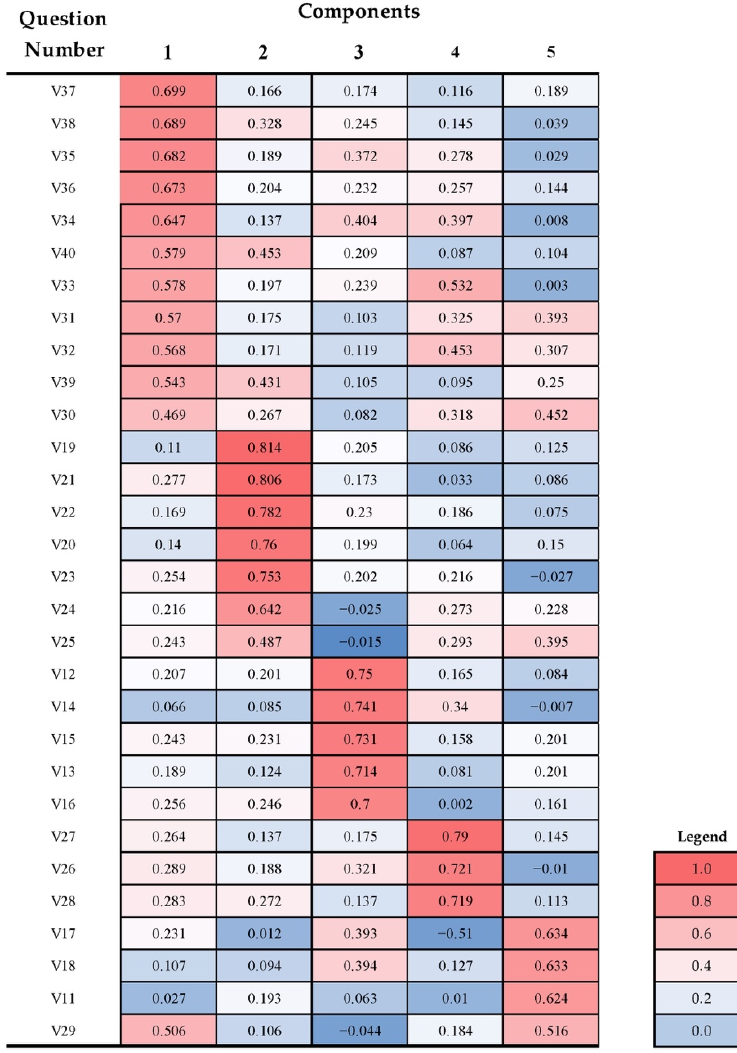
Figure 3. Component matrix diagram after rotations (Data: compiled by this research).